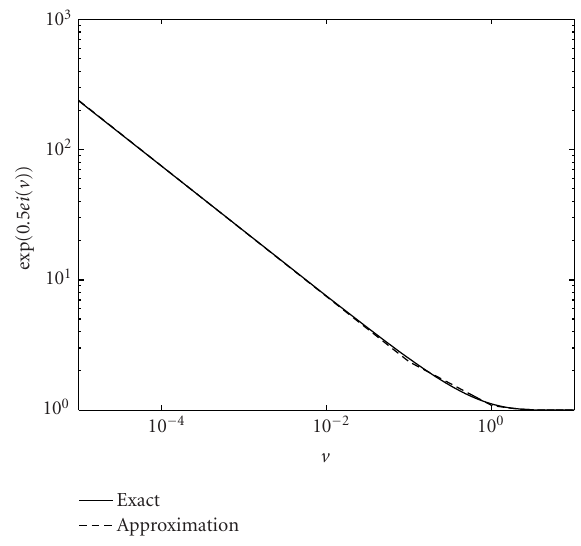
Figure 4: An approximation of exp(0 . 5 ei ( v )) using the approxima- tion for ei ( v ) in